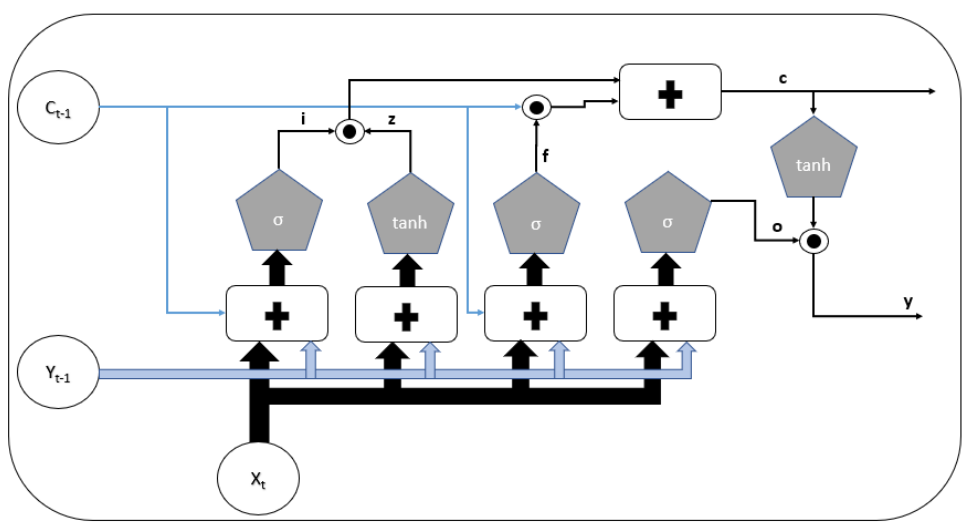
Figure 1. Visualization of a basic LSTM cell